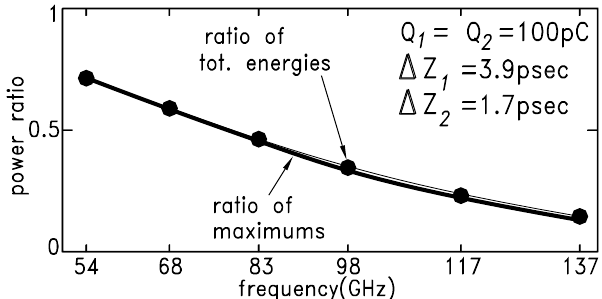
FIG. 9. Ratio of power emitted into each channel (fixed wave- length) for two different bunch lengths (3.9 and 1.7 psec) and charges (166 and 105 pC). The two curves nearly overlaying each other describe two ways of forming that ratio: using the total energy transmitted by the filter see Eq. (7), or using the maximum of the filtered transmitted power see Eq.